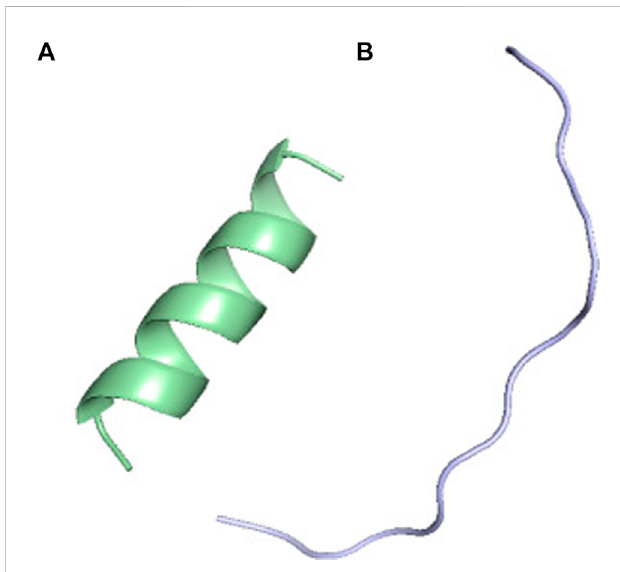
FIGURE 2 PF-DH Conformational ensemble of (K)15 as a function of pH. (A) pH 7.4 (B) pH 13. Only the lowest energy model (rank 1) is depicted.